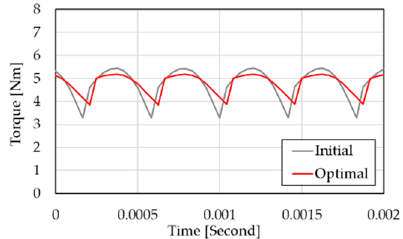
Figure 12. Comparison of the rated torque characteristics.